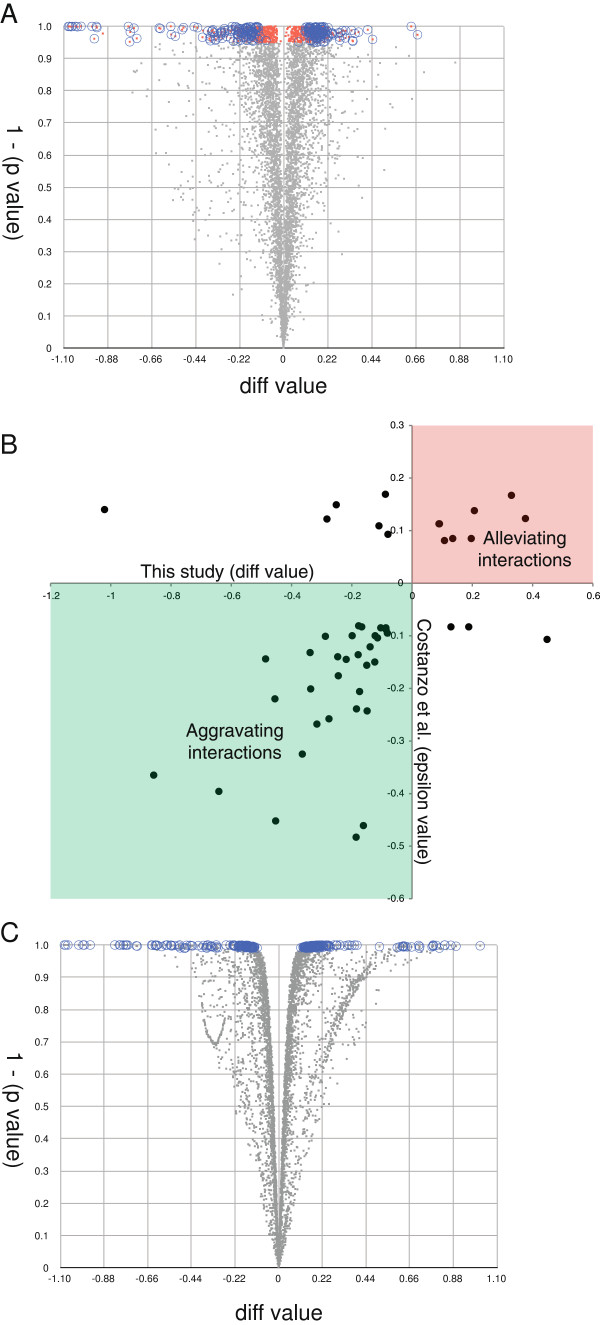
Summary of our SCS2 SGA experiment. A. Correlation of diff value with p value. Gray: p value > 0.05; red: p value < 0.05; circled red points: p < 0.05, diff above or below threshold in three replicates. B. Difference values in our screen plotted on the x-axis against epsilon values from the Boone lab data set on the y-axis. C. Correlation of diff value with p value using Bayesian analysis with Cyber-T. Gray: p value > 0.01; circled points: p value <0.01.